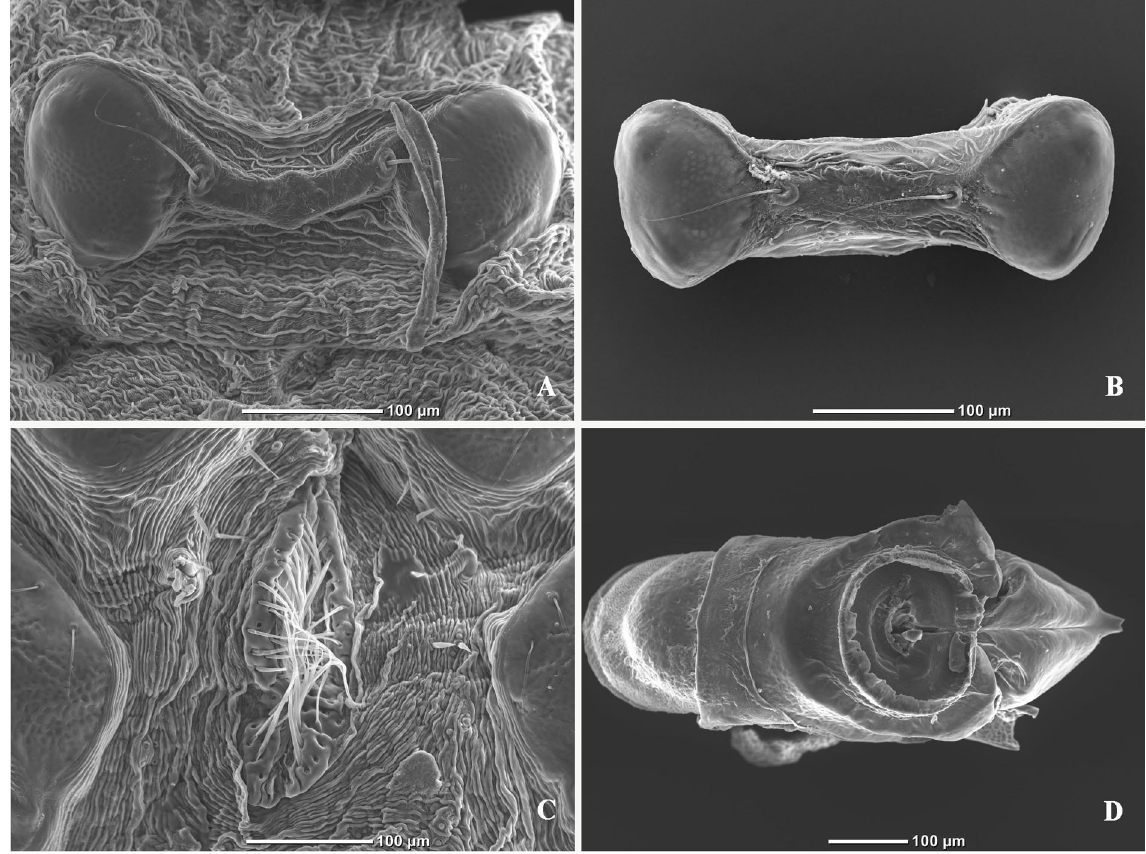
Fig. 2. Eylais ( Meteylais ) hamata Koenike, 1897, SEM photographs, ♂. A . GUGC QH-EY-20200802. B–D . GUGC QH-EY-20200803. A . Eye plate (curved). B . Eye plate (straight). C . Genital field (cuticle crumpled). D .